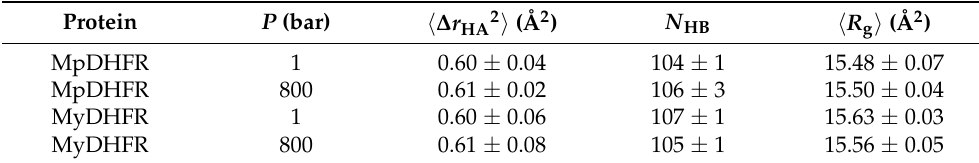
Table 1. Average properties from the 50 ns MD simulation. Average heavy atom mean-square fluctuations, (cid:104) ∆ r HA2 (cid:105) , number of hydrogen bonds, N HB , and radii of gyration, R g .